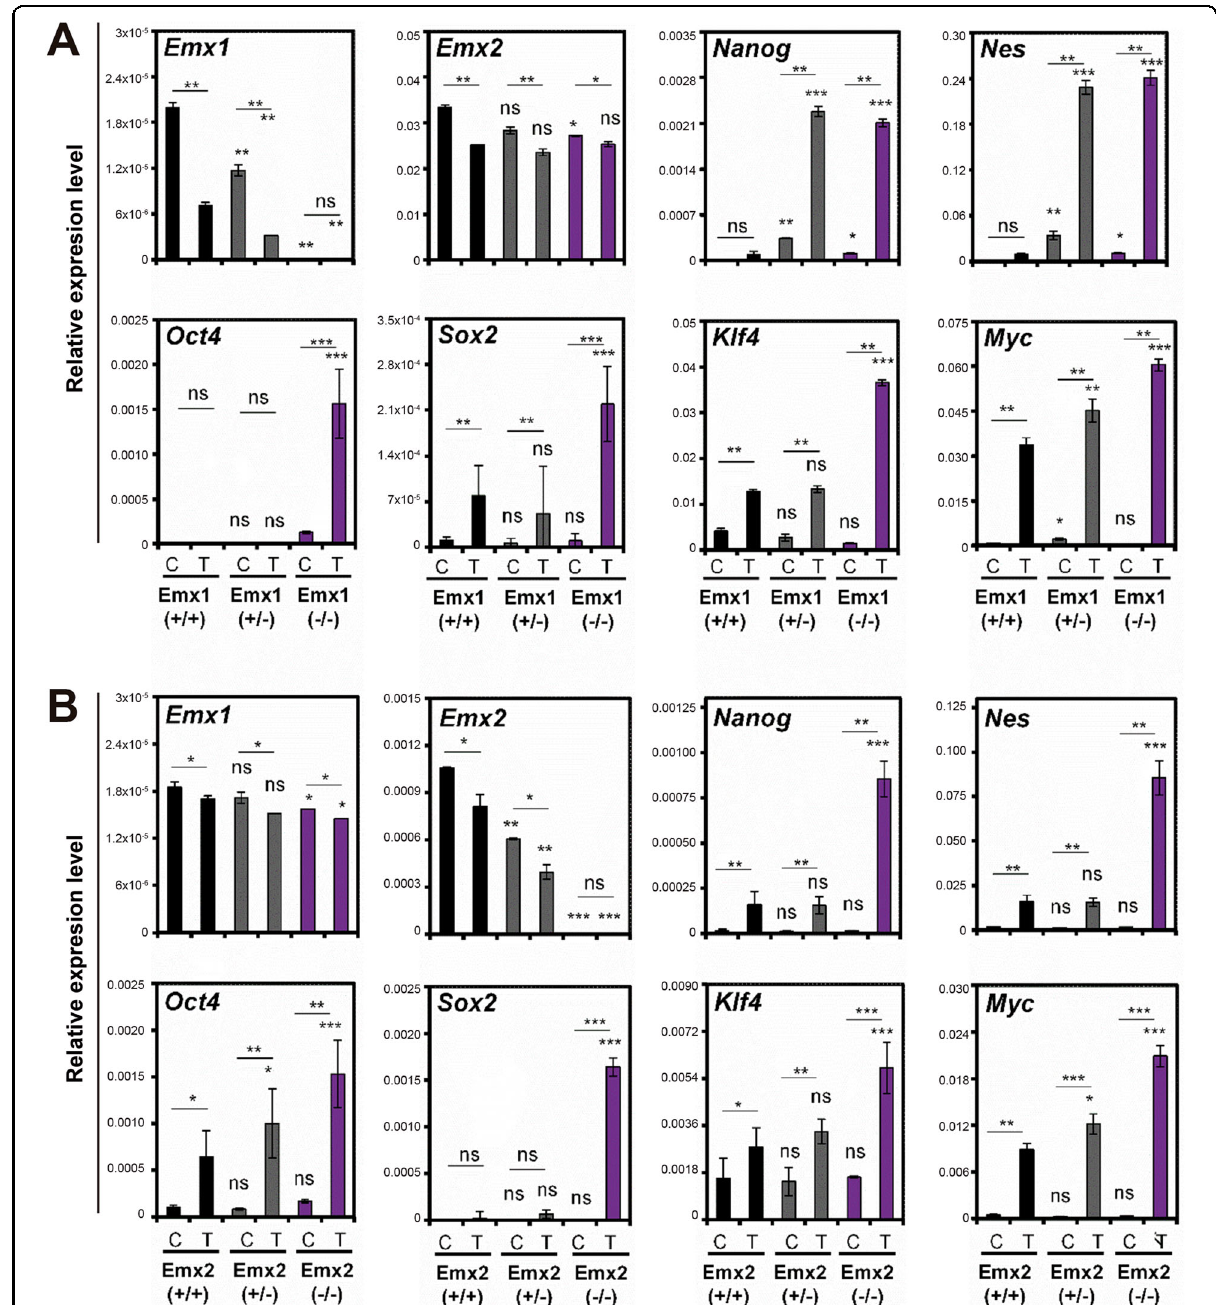
Fig. 7 Analysis of the expression levels of the regulatory genes of stem cell biology in 3MC-induced sarcomas of the Emx1 and Emx2 KO mice. A , B Results of the relative expression (2 − Δ Ct ) of Emx1, Emx2, Nanog, Nes, Oct4, Sox2, Klf4, and Myc in the different murine cohorts of Emx1 ( A ) and Emx2 ( B ) KO mice. The control muscle tissue is C and 3MC-induced sarcoma tumor tissue (T). The mean of a minimum of three independent experiments is represented in triplicate ± SD. Statistical analysis was performed with Student ’ s t -test (* p < 0.05; ** p < 0.01; *** p <